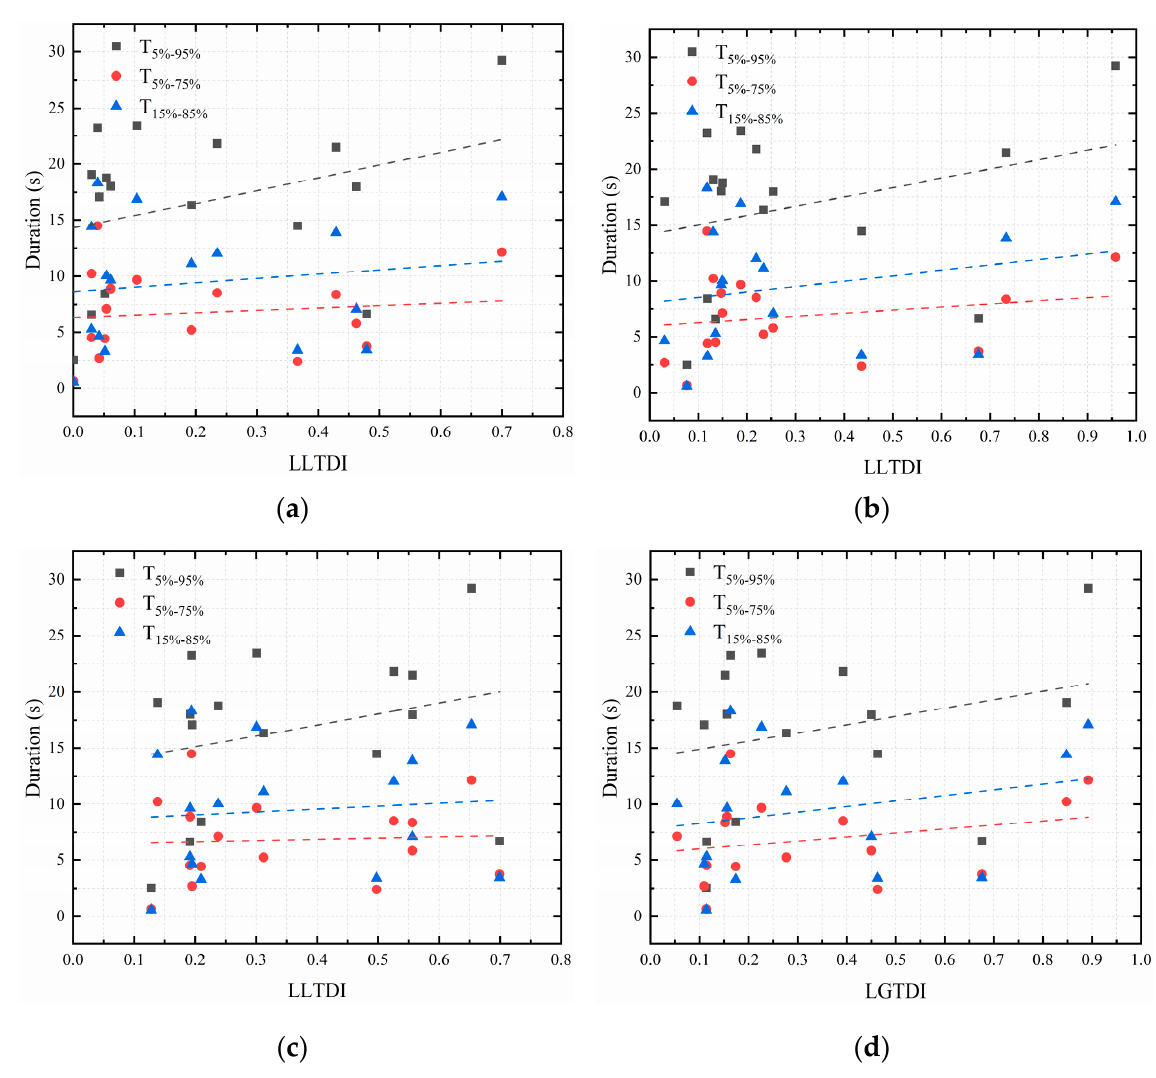
Figure 11. The LLTDI and LGTDI for concrete lining under NFGM with different EVDs. ( a ) arch section ( b ) sidewall section ( c ) bottom section ( d ) overall.